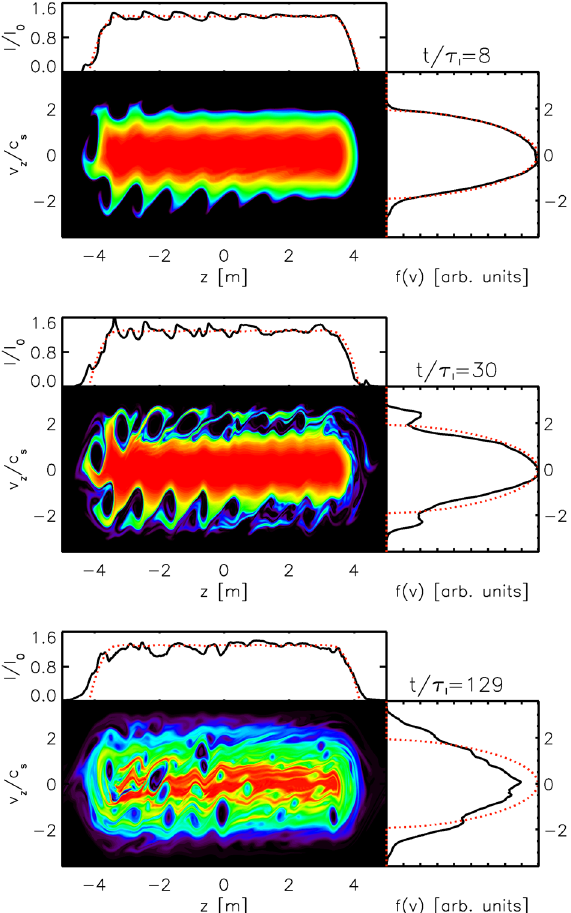
FIG. 9. (Color) Time evolution of the microwave instability in a barrier bucket for U (cid:4) 0 : 3 , V (cid:4) 0 : 3 , and n dotted curves represent the initial current profile and velocity distribution.